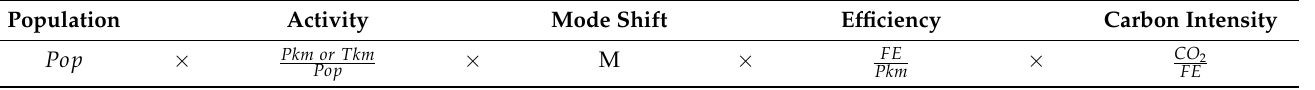
Table 1. Decomposition formula for transport. Population Activity Mode Shift Efficiency Carbon